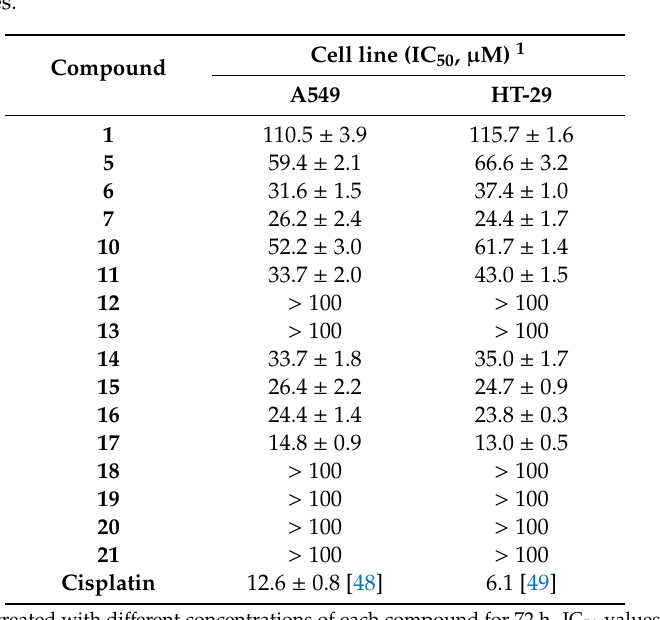
Table 1. Antiproliferative activities of GA 1 , its derivatives 5 – 7 and 10 – 21 , and cisplatin against A549 and HT-29 cell lines.